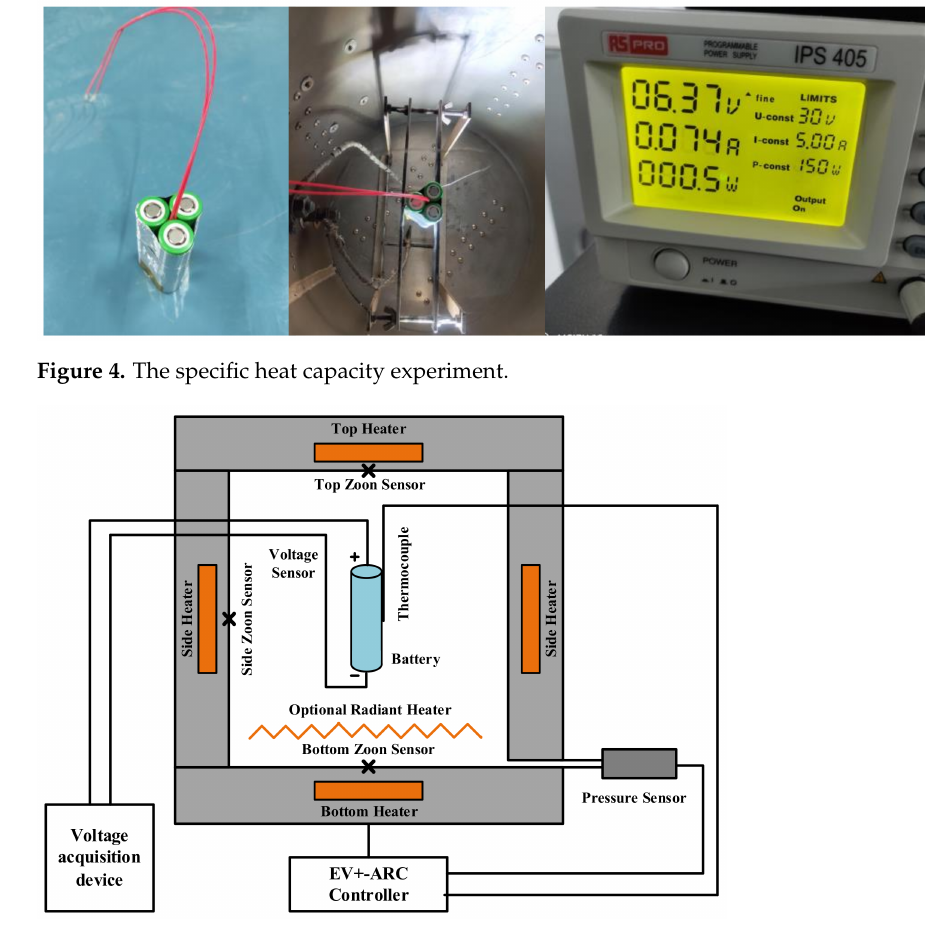
Figure 5. The schematic diagram of the TR